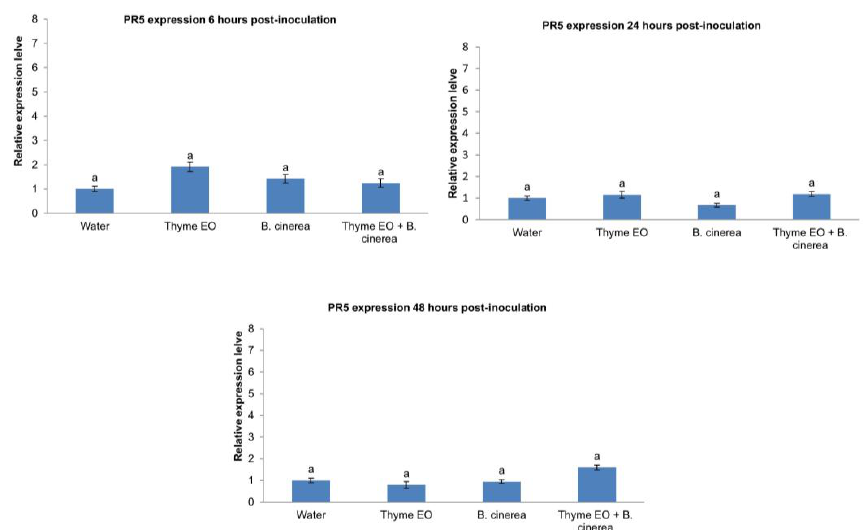
Figure 3. Expression of pathogenesis-related gene PR-5 in apple fruit in response to wounding, thyme essential oil, and B. cinerea at different time points (6 h, 24 h, and 48 h). Vertical lines represent the standard error for the average of three biological replicates. Different letters above the columns indicated a significant difference determined by Duncan’s multiple comparison test ( p < 0.05).